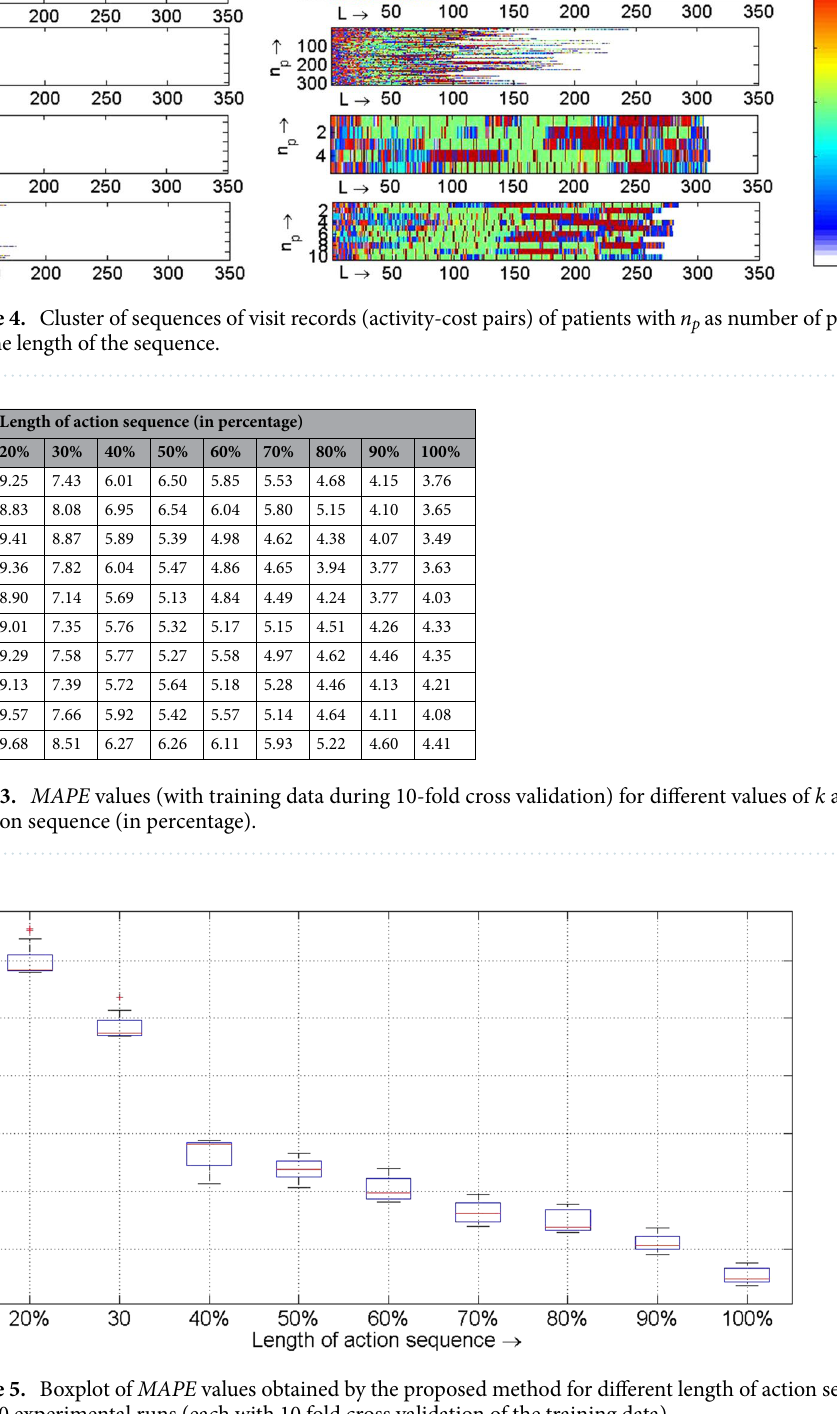
respective critical value of 7.815 following χ 2 F distribution with 3 degrees of freedom at α = 0.05. It substantiates statistically significant difference between the MAPE measures obtained by the proposed algorithm and each of its contenders. The results in Table 7 highlights the proposed method as the best algorithm, so the Bonferroni–Dunn post- hoc analysis 20, 21 is performed with the proposed method as the control method. For the Bonferroni–Dunn test, a critical difference value is calculated which for these data (represented by Table 7) comes as 1.457. A significant